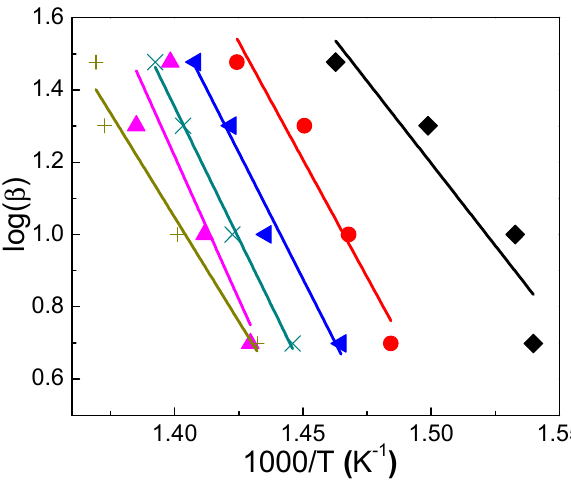
Figure 13. Plot of log ( β ) vs. 1000/ T for sample PS/Mg2ZnAl-AAC (15 wt.%) at ♦ α = 0.1, ● α = 0.2, (cid:31) α = 0.3, × α = 0.4, ▲ α = 0.5, and + α = 0.6.